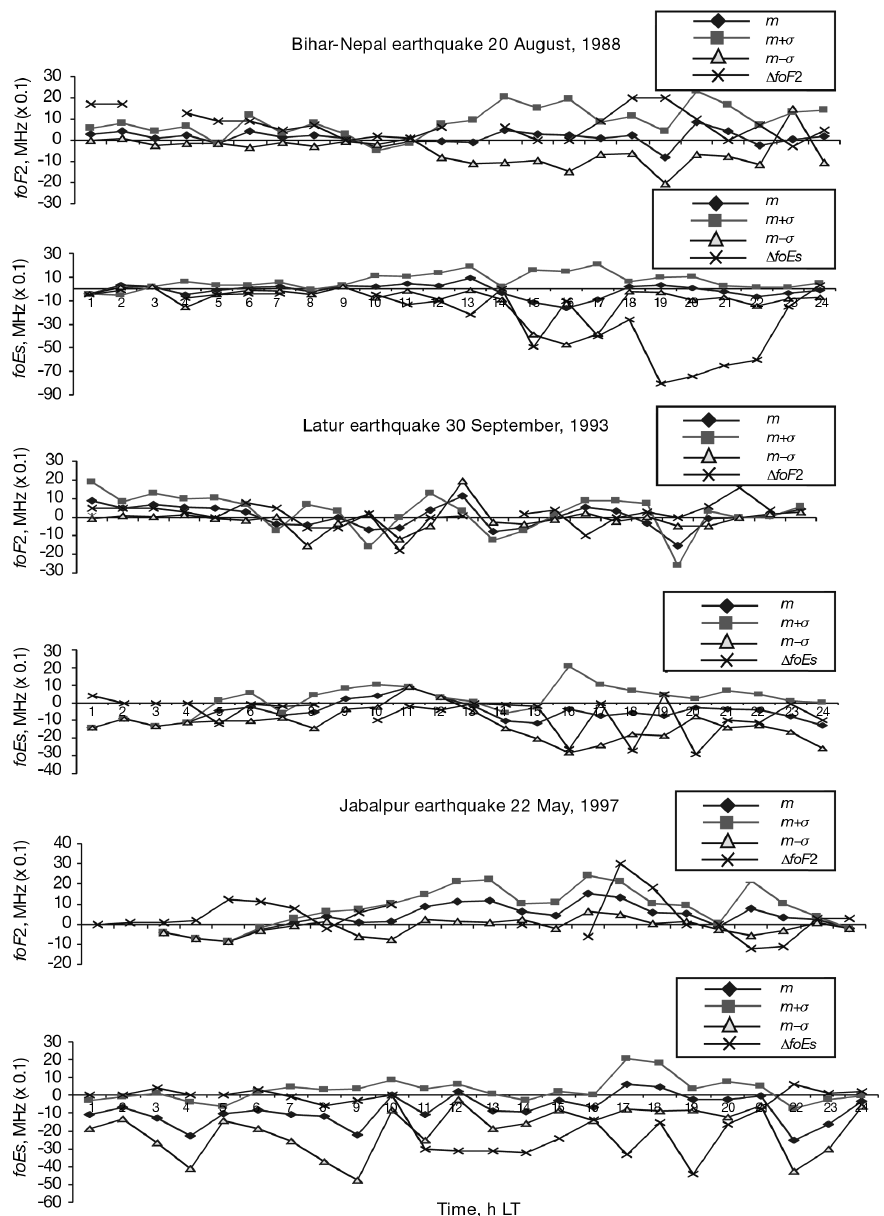
Fig. 4. Statistical results showing the deviation of foF 2 and foEs from the monthly median on the day it was lowest in the month of the earthquake ( ∆ foF 2 and ∆ foEs ). The mean ( m ) and standard deviation ( σ ) around mean ( m ± σ ) are computed for the same days in the past ten years of data on which Sun spot numbers were nearly